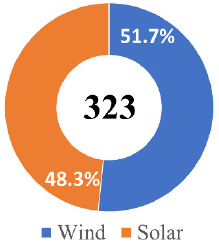
Figure 7. Occurrence of “wind” and “solar” references in most frequent words (LCOE).